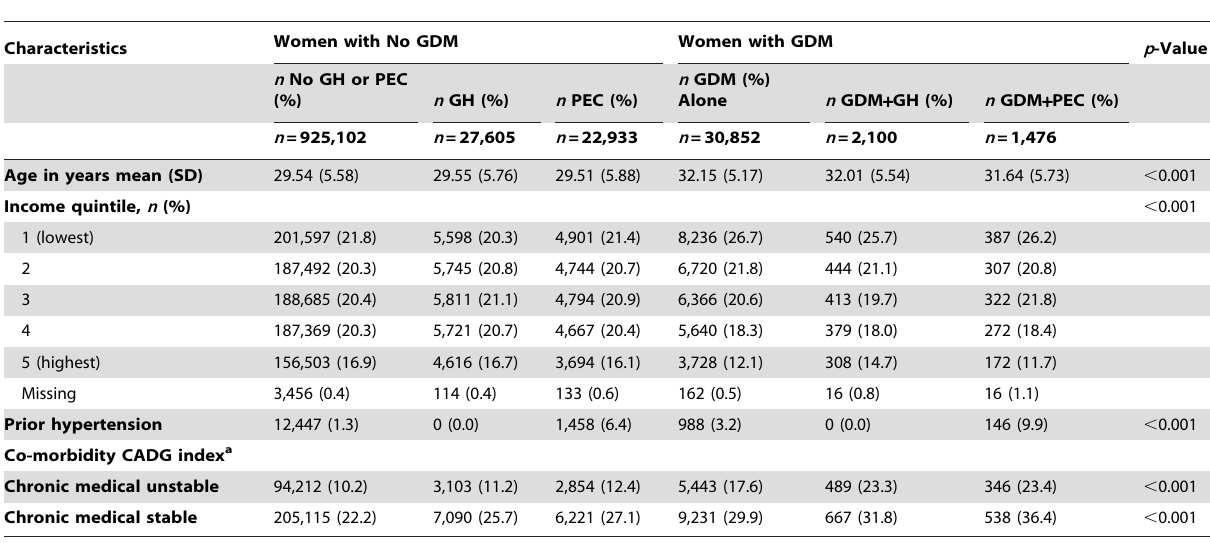
Table 1. Demographic and clinical characteristics of women stratified by gestational diabetes diagnosis.